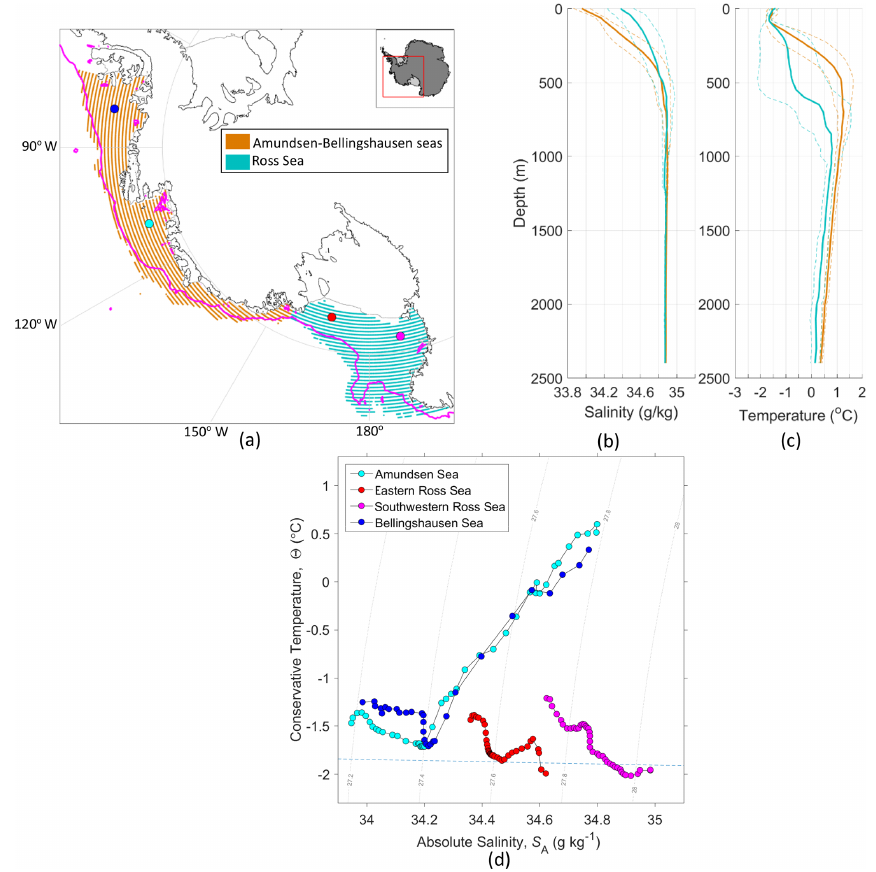
Figure 1. (a) The study domain of Amundsen–Bellingshausen seas and Ross Sea with bathymetry above 2500m. The magenta line indicates the 1000m IBCSO depth contour. Panels (b) and (c) show geographically averaged decadal (1995–2004) WOA salinity and temperature pro- files in the Amundsen–Bellingshausen seas (orange; corresponding to the orange stippled region in a ) and the Ross Sea (cyan; corresponding to the cyan stippled region in a ). Dashed lines indicate ± 1 SD of values at each depth in each region. (d) T – S properties of selected water columns (corresponding to colored circles in a